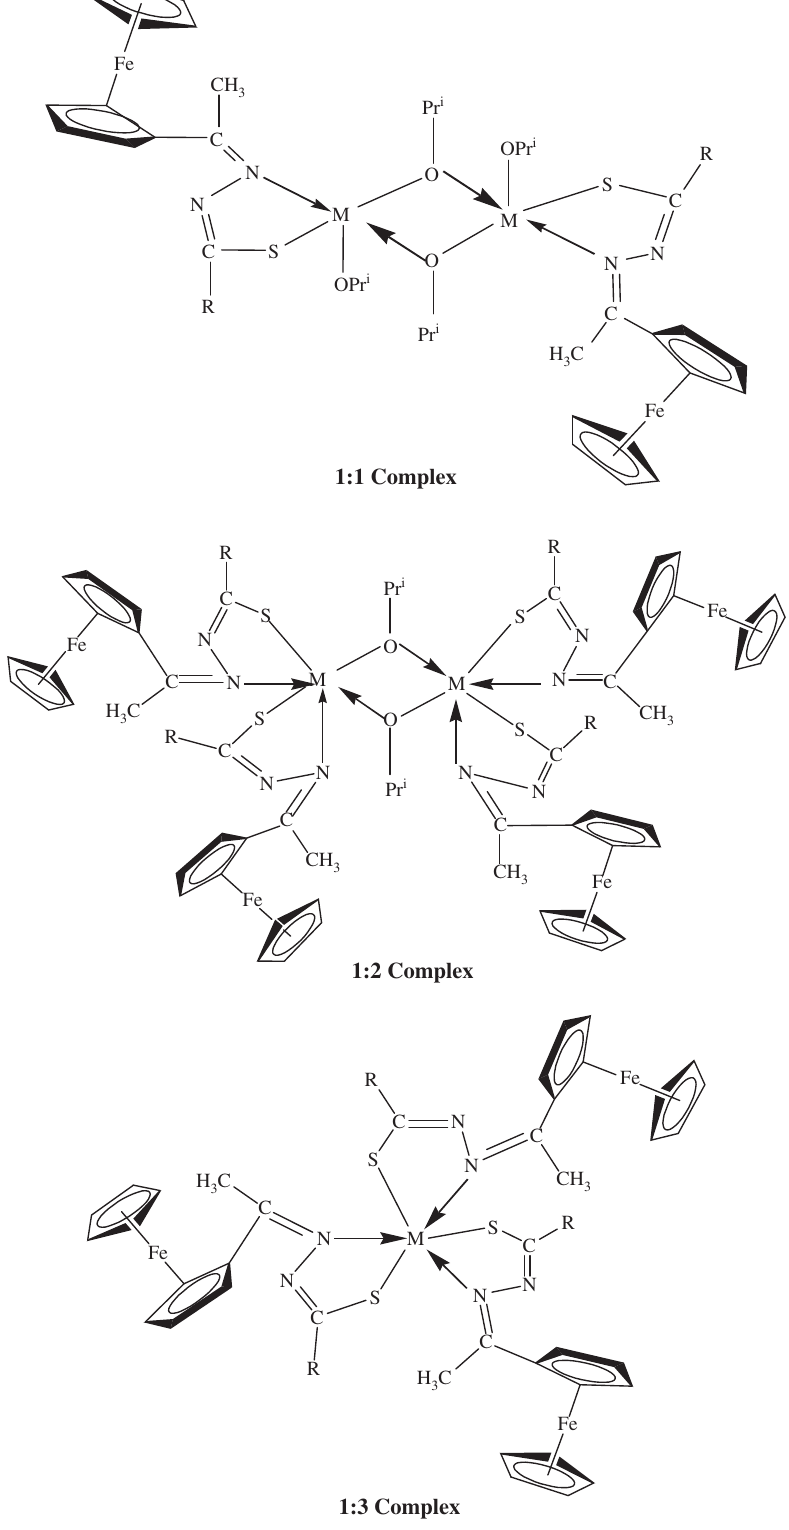
Figure 1 Proposed structures of the synthesized metal